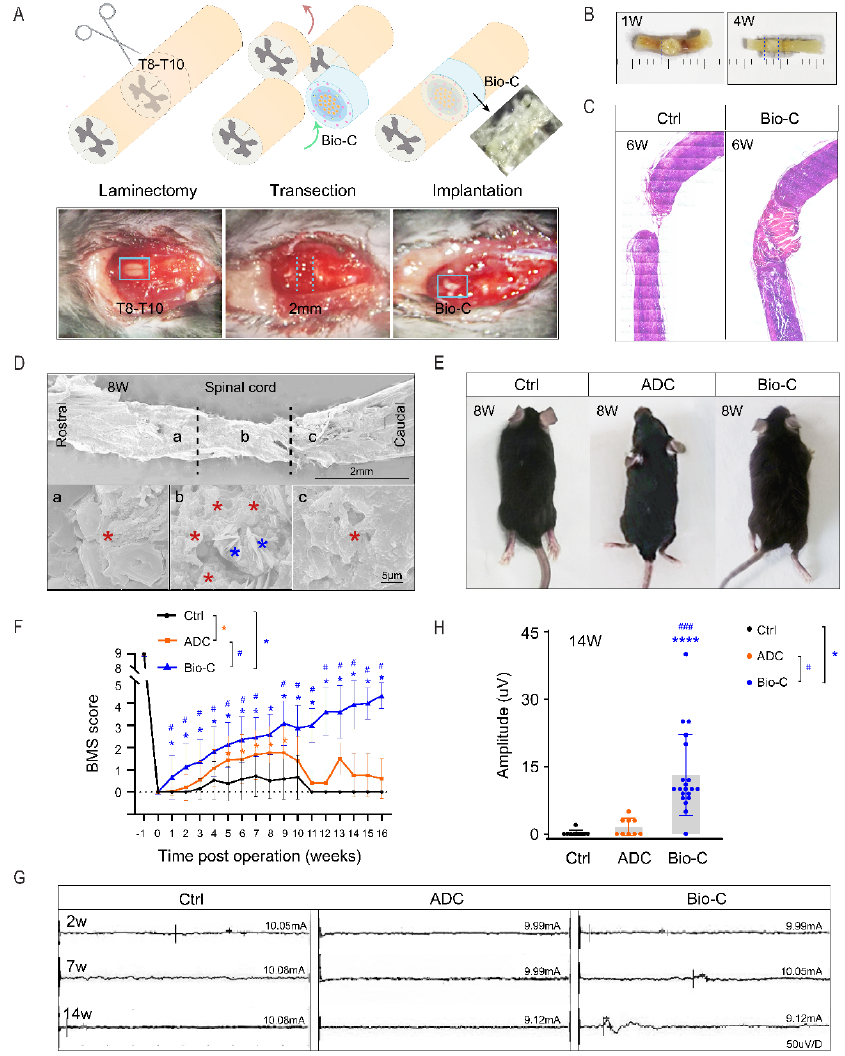
Figure 2. Bio-C promoted regeneration and functional recovery after complete SCI. ( A ) Schematic illustration of complete transection and segment removal SCI model (upper panel) and images of mice complete transection surgery (lower panels), in which a T8–T10 thoracic spine was open (laminectomy) and 2 mm–segment spinal-cord tissue was removed (transection), followed by immediate Bio-C or ADC implantation in the lesion area (implantation). ( B ) Freshly dissected spinal-cord tissue with Bio-C implants isolated in 1 week (left) and 4 weeks (right) after SCI. ( C ) Images of HE staining showing the difference of spinal-cord morphology with and without Bio-C implants at the 6 weeks after SCI. ( D ) Scanning electron micrographs showing spinal cord with Bio-C implants at 8 weeks after SCI. Red star indicates spinal-cord tissues, and blue star indicates Bio-C residue in tissue. ( E ) Different hind-limb recoveries in SCI (control), ADC, and Bio-C groups at 8 weeks after surgery. ( F ) Statistical diagram showing animal hind-limb motor-functional recovery after SCI in BMS open-field test (mean ± SEM; blue # indicates the difference between Bio-C and ADC mice; blue * indicates differences between Bio-C and SCI mice; orange * indicates differences between ADC and SCI mice; *# p < 0.05, N ≥ 165, n ≥ 3 unpaired Student’s t -test with comparisons of all three groups at each time point, up to 16 weeks). ( G ) Electrophysiological analysis of SCI mice with and without ADC and Bio-C implants at 2, 7, and 14 weeks after SCI. Schematic graph to show the MEP recording and representative MEP traces. Note that only the Bio-C group showed partial recovery at 14 weeks. ( H ) Statistics diagram showing significant MEP amplitude differences among SCI/control, ADC, and Bio-C groups at 14 weeks after SCI. (Mean ± SEM, n ≥ 3; **** p < 0.0001, and ### p < 0.001; unpaired Student’s t -test.) Both SCI and ADC groups had little MEP